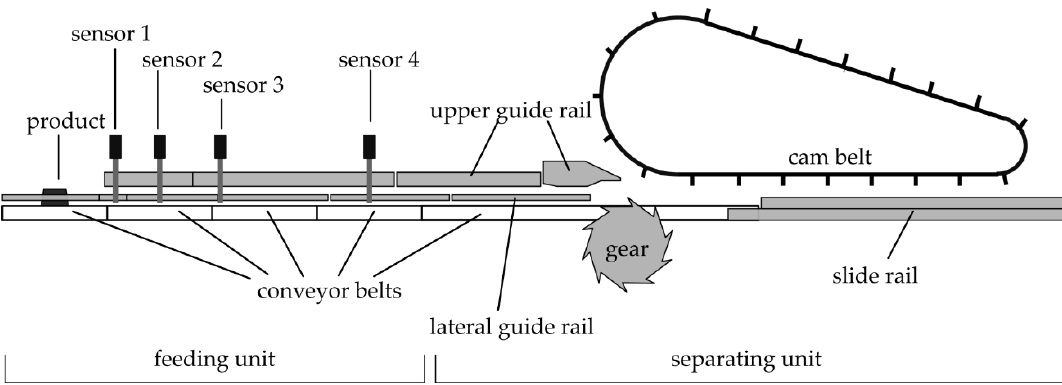
Figure 3. Schematic structure of the investigated